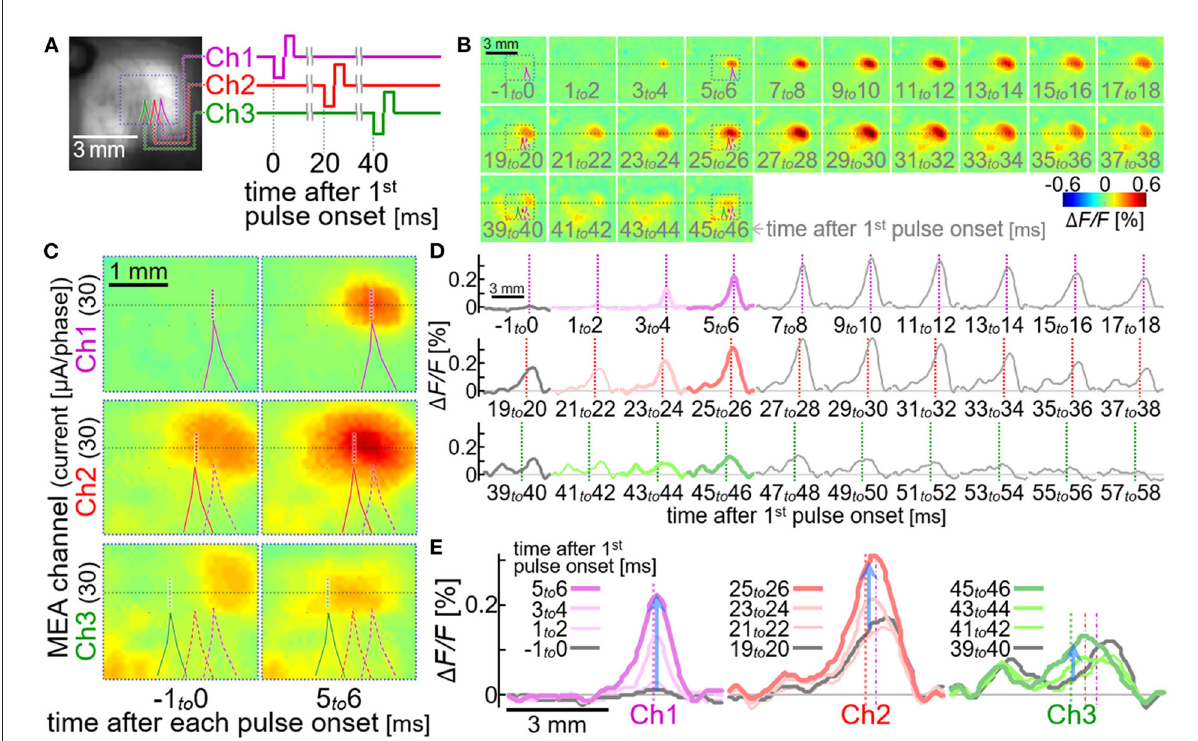
FIGURE8 Sequential multi-site neural excitations with using the stimulation module. (A) VSD fluorescence image of the cortex. Colored lines indicate the outlines of shadows of three stimulating electrode shafts, Ch1, Ch2 and Ch3. The diagram on the right shows timing of the stimulus pulses delivered from the three electrodes. (B,C) Pseudo-color time-lapse 1 F/F images induced by the sequential stimulation. The images in (C) show expanded views of the VSD images in the dotted boxes in (B) . All the dotted boxes in (A–C) represent the same region on the cortex in the animal. (D,E) Spatial line profiles of the VSD signal along the line in (B) . Colored profiles in (D) are expanded and superimposed in (E). Upward blue arrows represent the positions and the amplitudes of the maximum increases in VSD signal induced in 5–6 msec after the stimulus